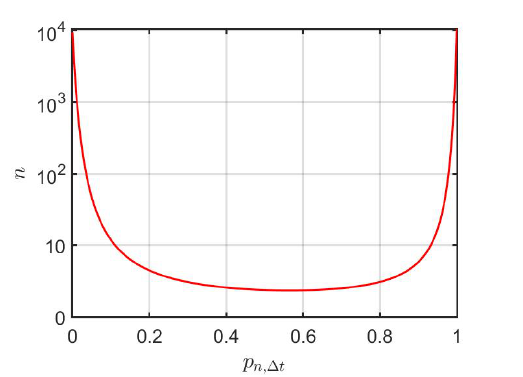
( q ) ( n ) to S as a function of p n , ∆ t . S T T